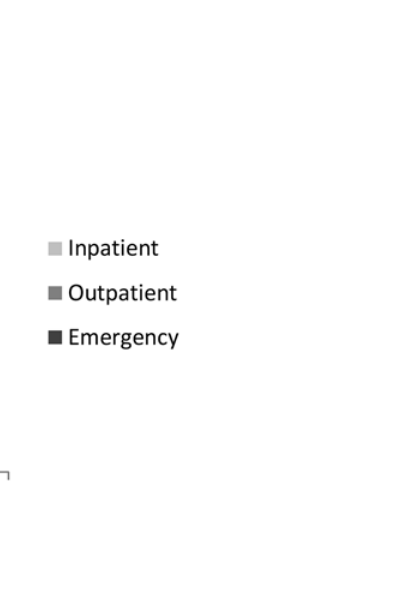
Fig 1. Age distribution of inpatients, outpatients and emergency department